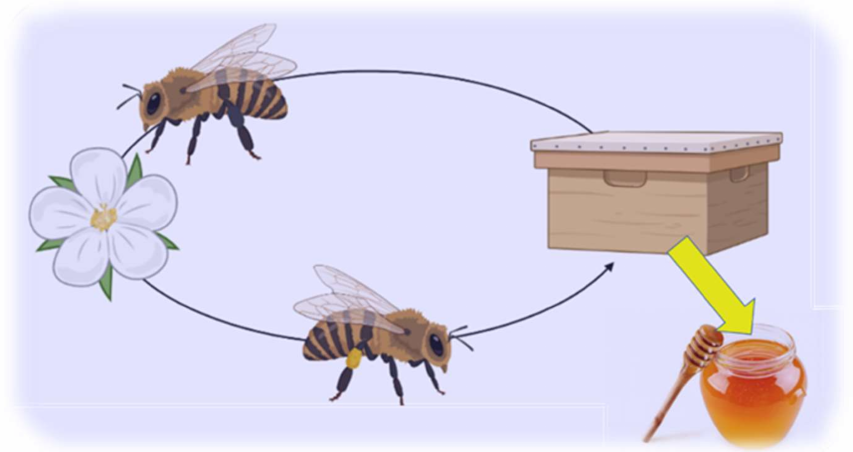
Figure 5. The traditional method for honey production starts with the bees visiting plant flowers to collect the nectar. Once the nectar has been extracted from the flowers, the bees use enzymes to digest the nectar into simpler compounds, mainly fructose and glucose, and store it in their